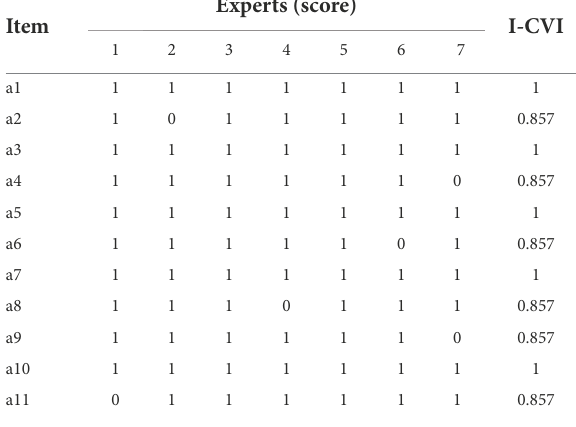
TABLE 4 Content validity analysis for the Chinese version of the ATREND scale.